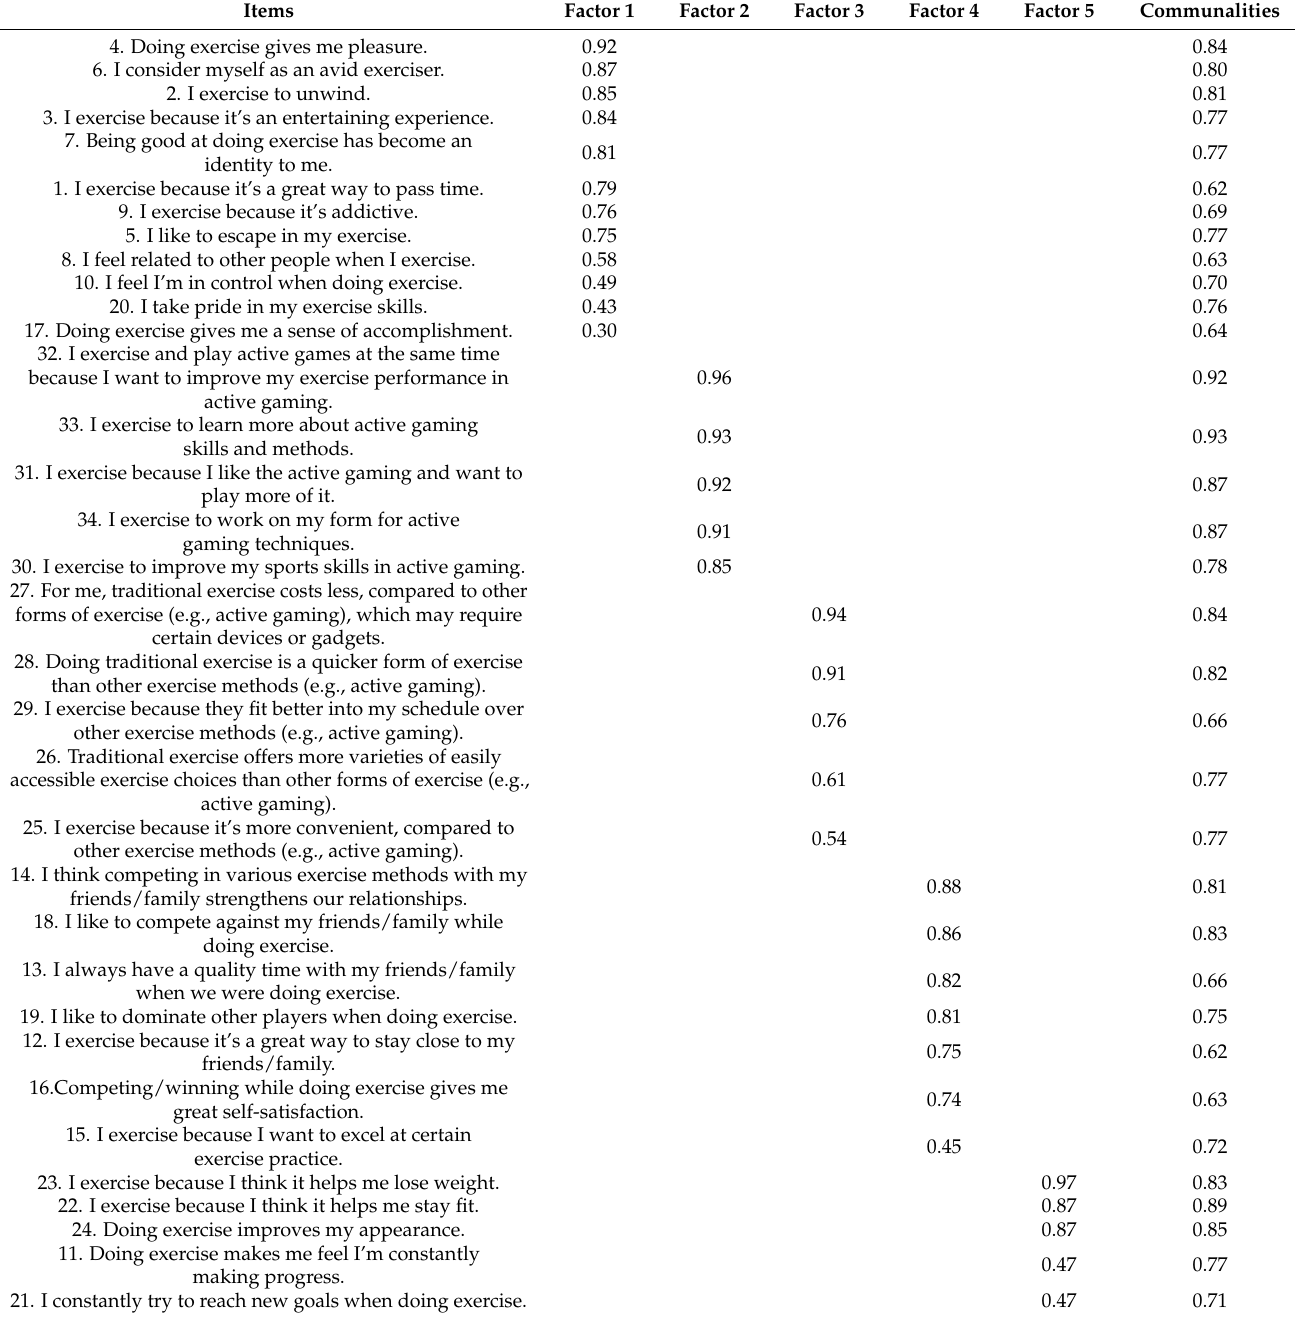
Table 2. Factor loadings and communalities for 34 items from